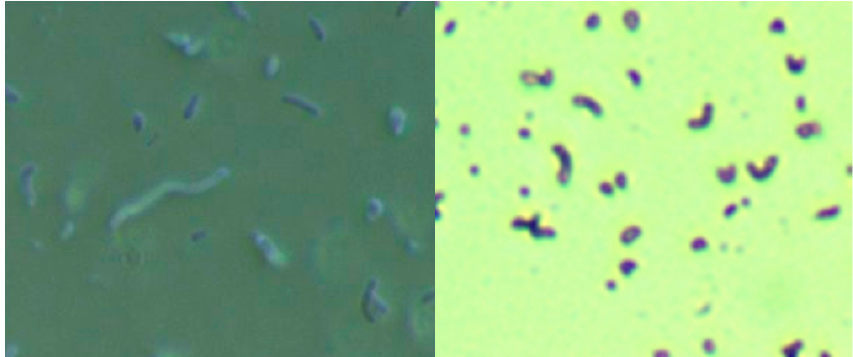
Figure 1. Culture of Borrelia burgdorferi and Helicobacter pylori from a Morgellons disease (MD) skin sample in modified Hp medium. Left Panel: Darkfield microscopy showing larger Borrelia spirochete surrounded by smaller organisms. Right Panel: Crystal violet stain showing comma-shaped Gram-negative organisms consistent with Helicobacter pylori . Both images were taken at 1000 × magnification.